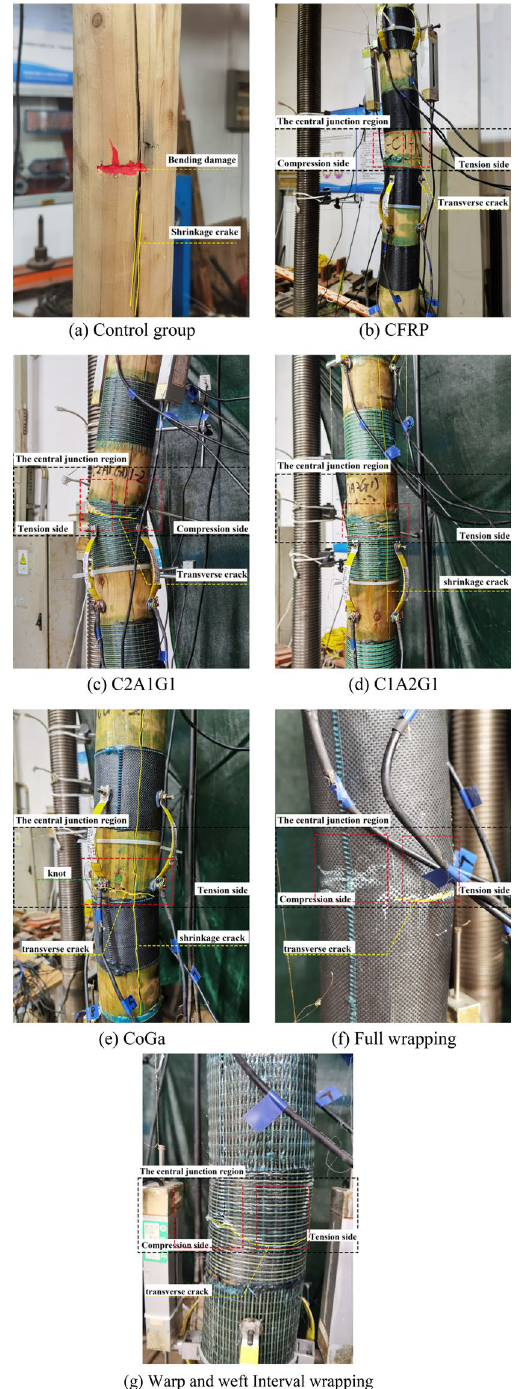
Fig. 11 Typical failure modes of timber